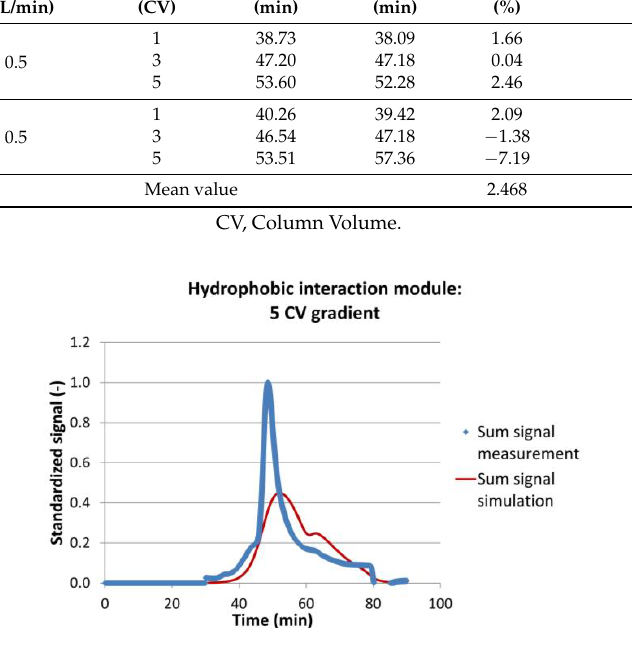
Figure 9. Experimental (blue dots) and simulation (red line) results for the hydrophobic interaction module with a 5 Column Volume (CV) gradient, as an example for simulation results with a low coefficient of determination ( R ² = 0.647).